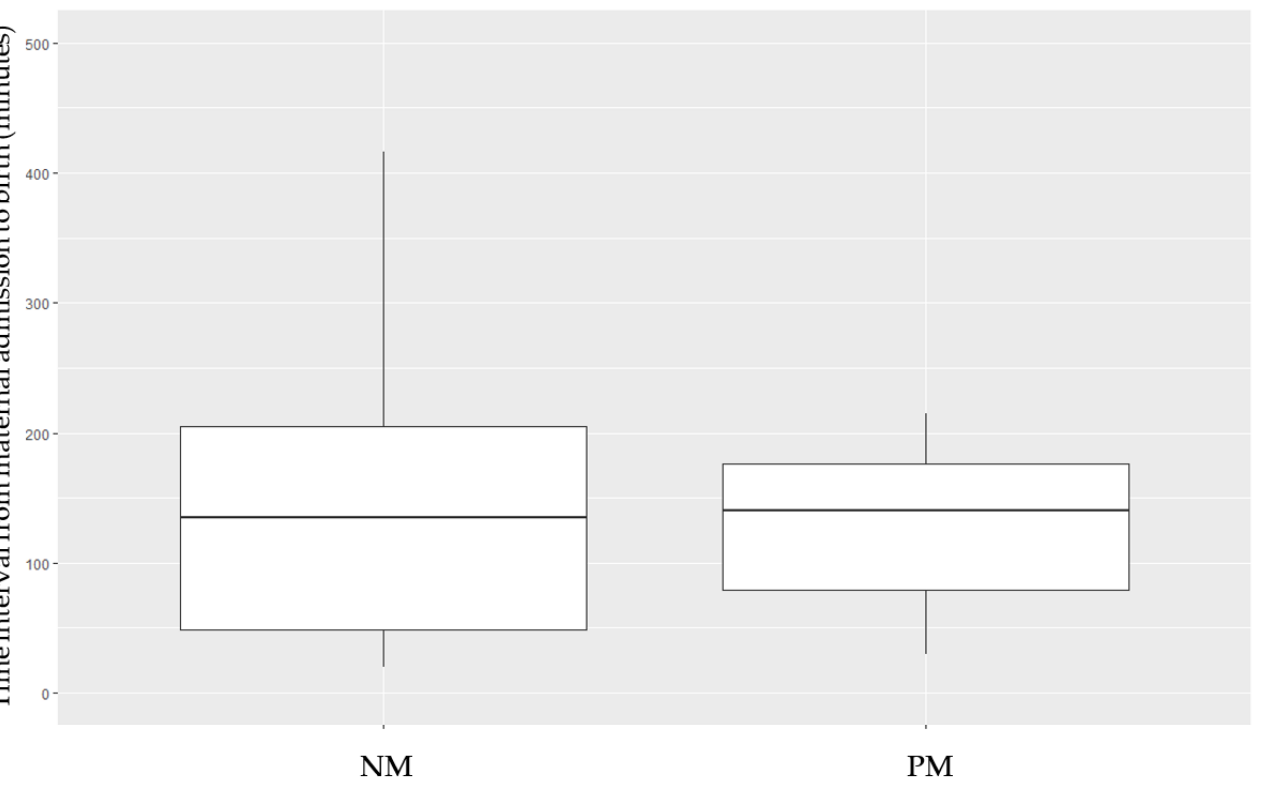
Figure 1. Time interval (in minutes) from the admission of the pregnant woman to the birth of the preterm neonate, depending on the maturation pattern received. NM, non-matured. PM, partial maturation. Table 3. Comparison of the tertiary hospital birth population based on the maturation pattern